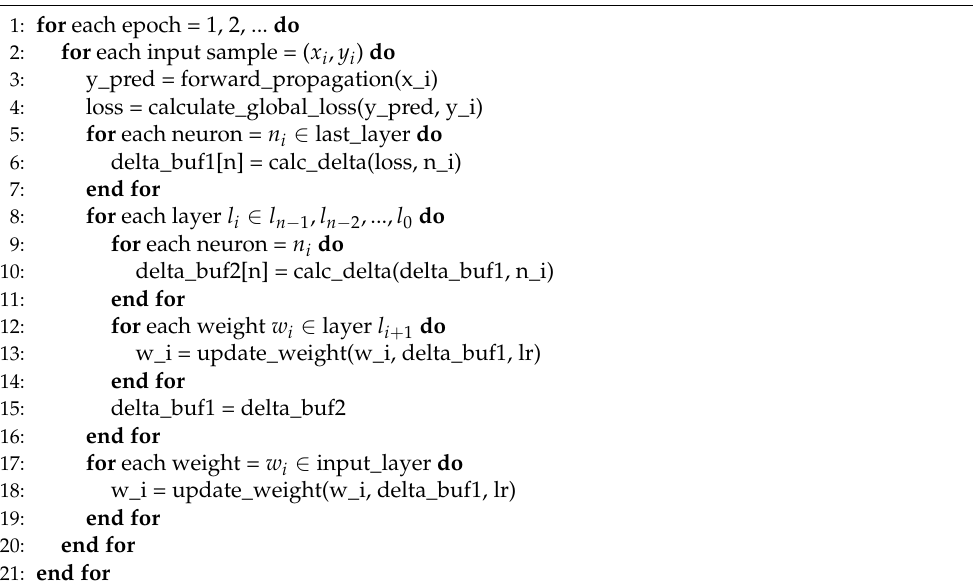
Algorithm 2 Implementation of